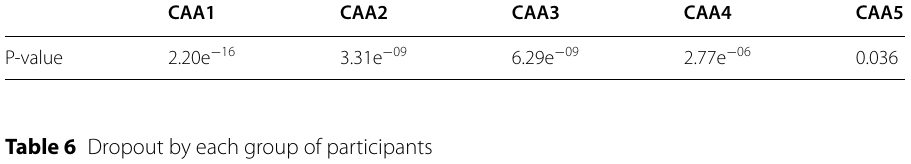
Table 5 Boschloo’s unconditional test for each activity CAA1